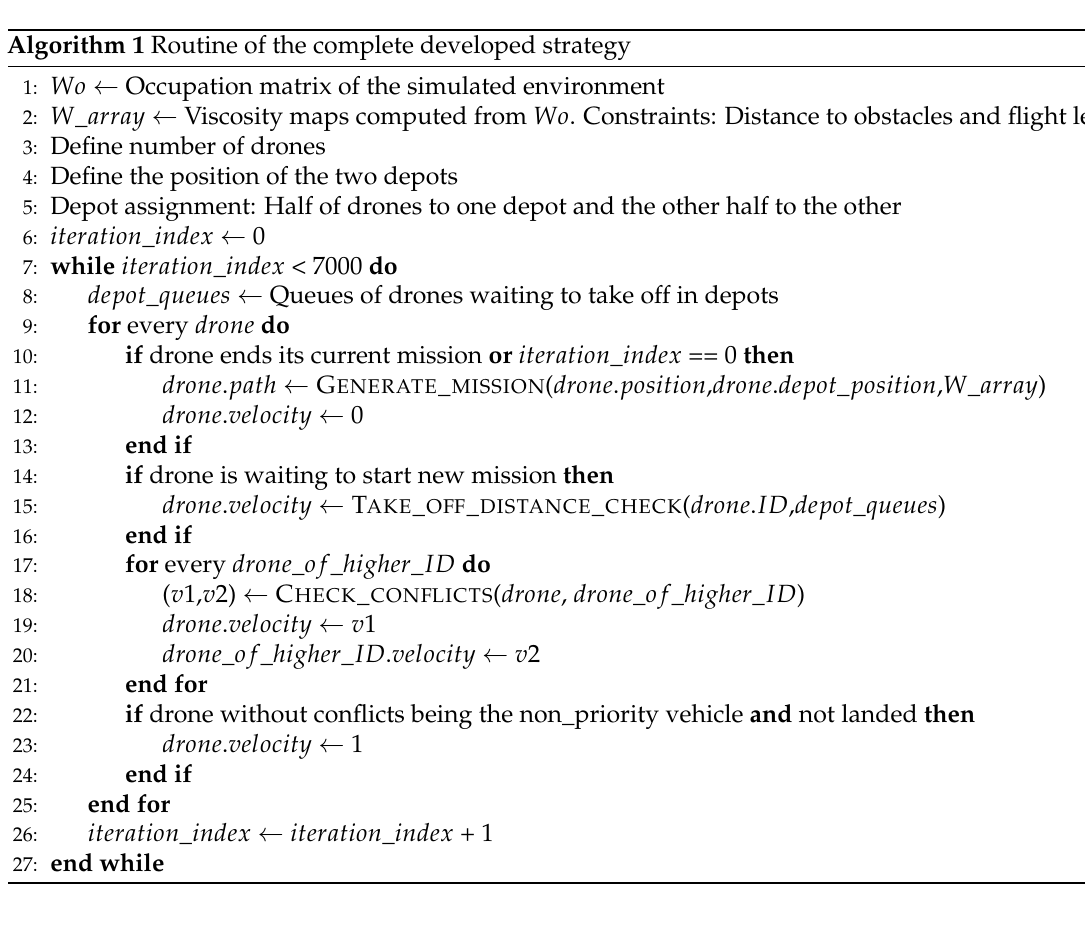
Algorithm 2 Trajectory planning using Fast Marching